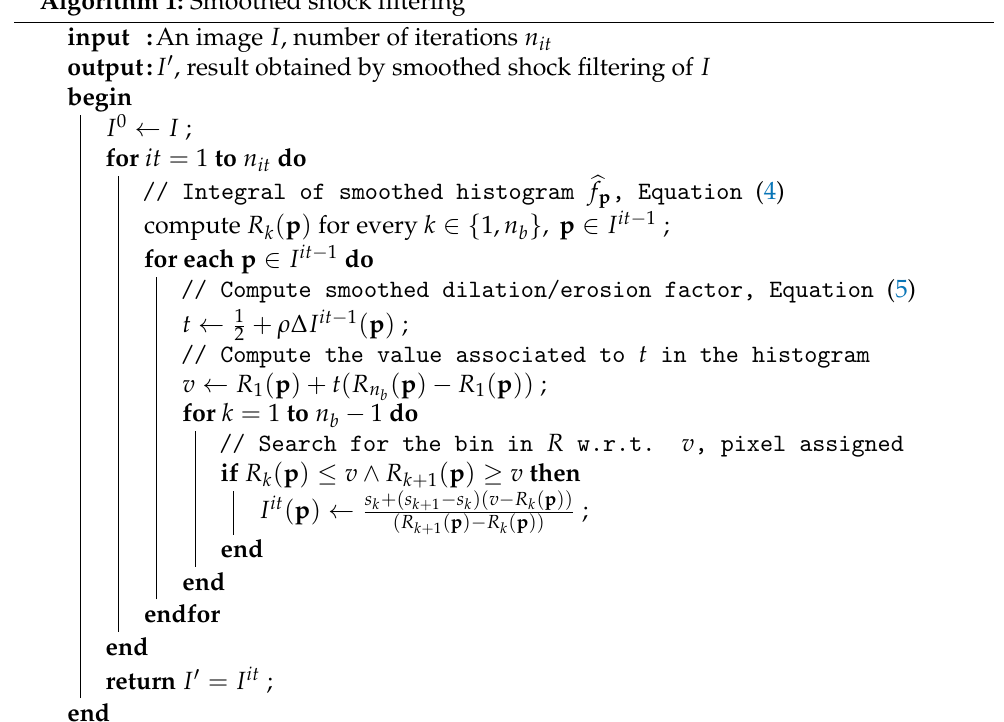
Algorithm 1: Smoothed shock filtering